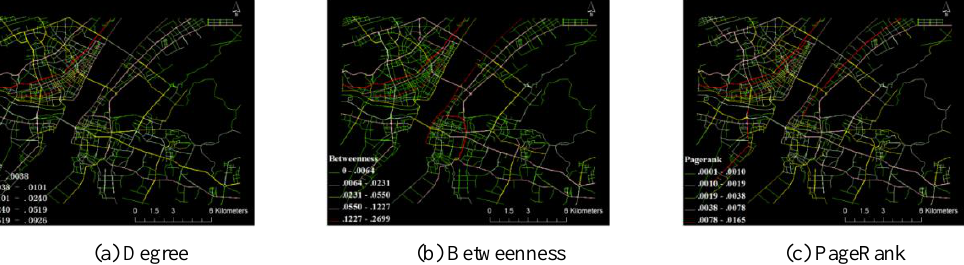
Figure 5. Spatial distribution of centrality in the roads